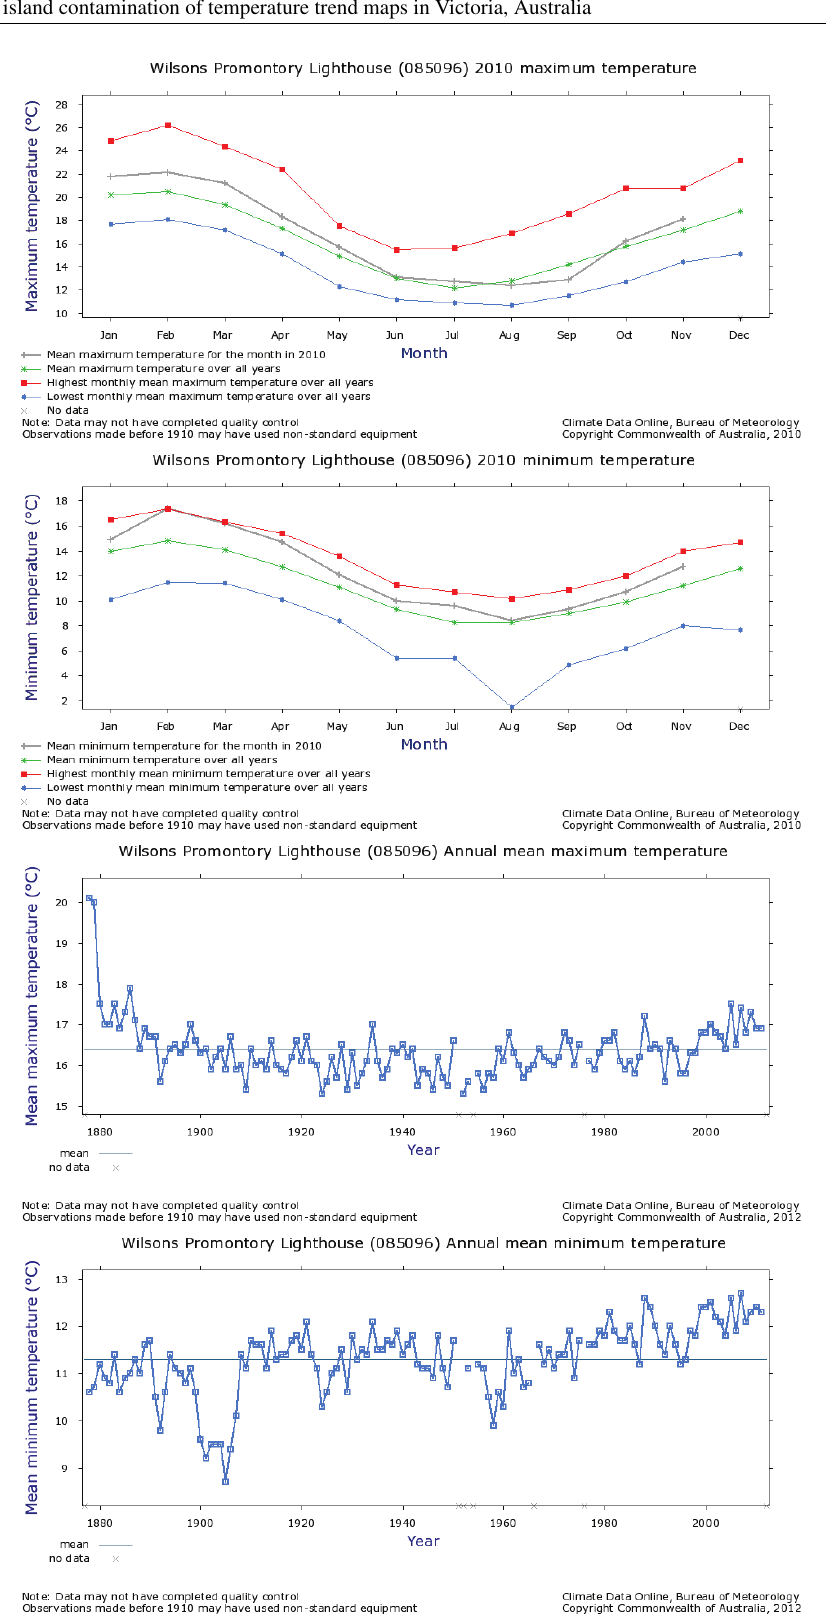
Figure 11. Australian Government Bureau of Meteorology temperature graphs for historical locations in Victoria, Aus-